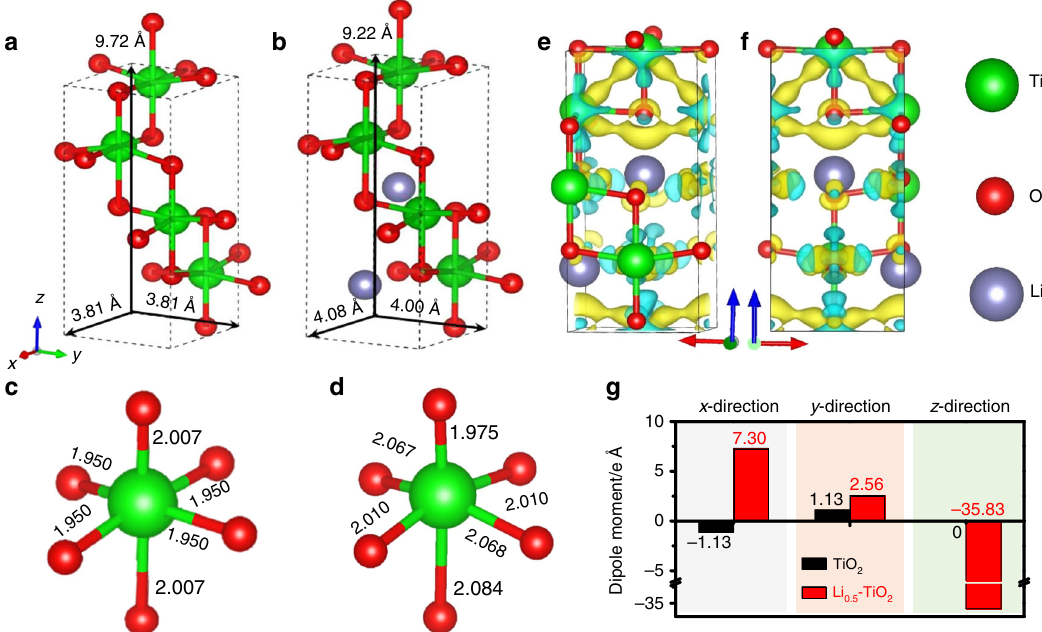
Fig. 2 Theoretical simulation of lattice distortion and dipole moment. a , b The lattice parameters of the structurally optimized anatase TiO 2 and orthorhombic Li 0.5 TiO 2 cells. c , d The theoretically determined Ti-O bond lengths of the unit cells of TiO 2 and Li 0.5 TiO 2 . e , f Deformation charge densities of Li 0.5 TiO 2 from two different lateral views of the x – z plane. The light yellow and blue surfaces represent the charge gain and loss, respectively. g The calculated dipole moments of TiO 2 and Li 0.5 TiO 2 along three different crystallographic directions.